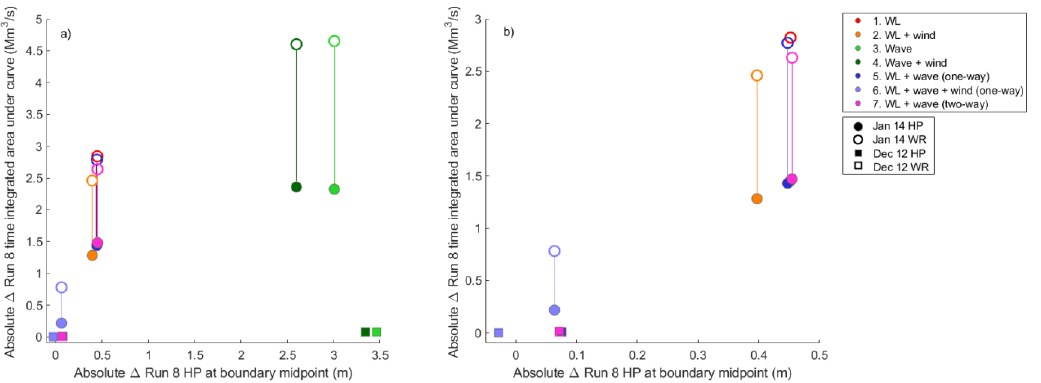
Figure 8. Absolute di ff erence in HP at the boundary midpoint (shown in Figure 1a) against absolute di ff erence in time-integrated volume for ( a ) all runs compared to baseline run 8 for each WR or HP simulation, depending on the approach used to force the model boundary.; and ( b ) zoomed into run 1, 2, 5, 6, and 7.